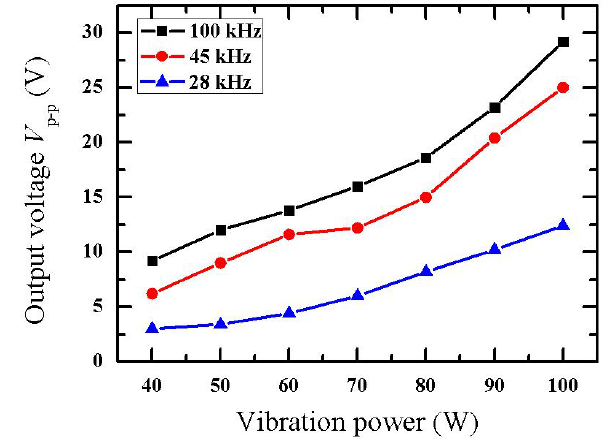
Figure 2. The piezoelectric voltage output as a function of ultrasonic vibration power at 28 kHz, 45 kHz and 100 kHz,